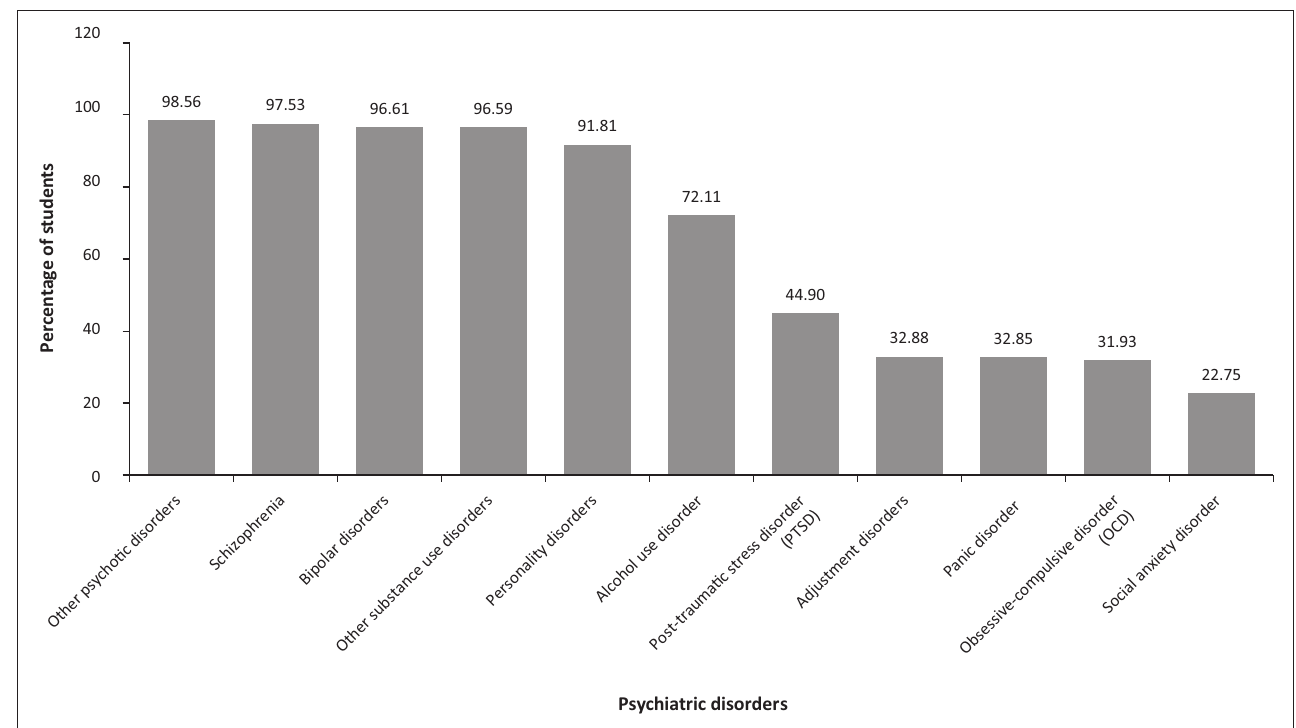
FIGURE 1: Proportion of students ( % ) exposed to different disorders from 2011 to 2015.